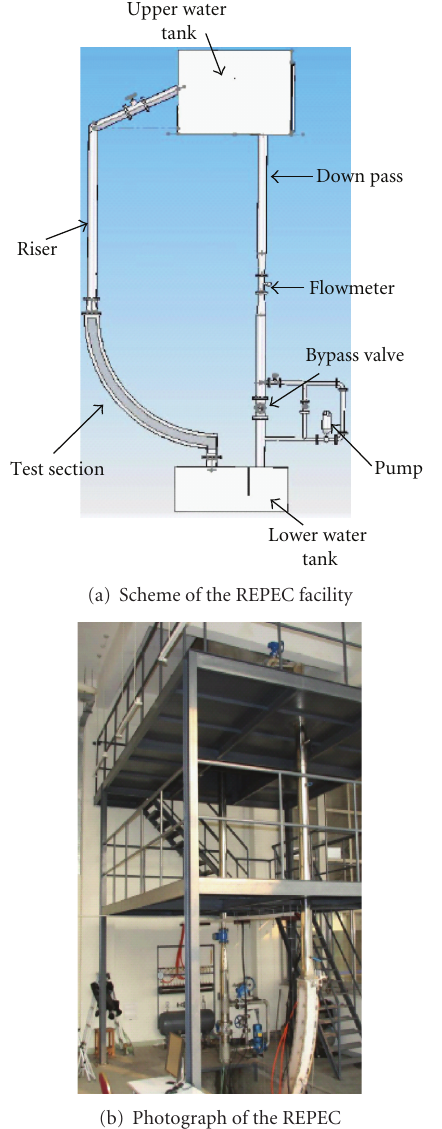
Figure 9: Test facility REPEC for ERVC-IVR.